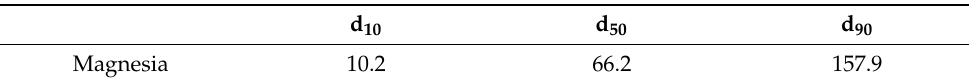
Table 2. Particle size distribution of MgO ( µ m).